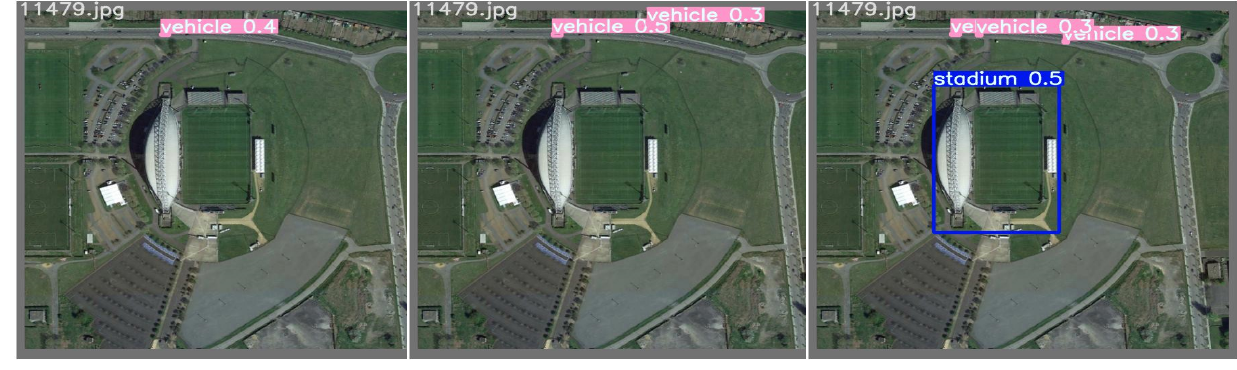
Figure 12. The detection results of small object instances in dense scenes.